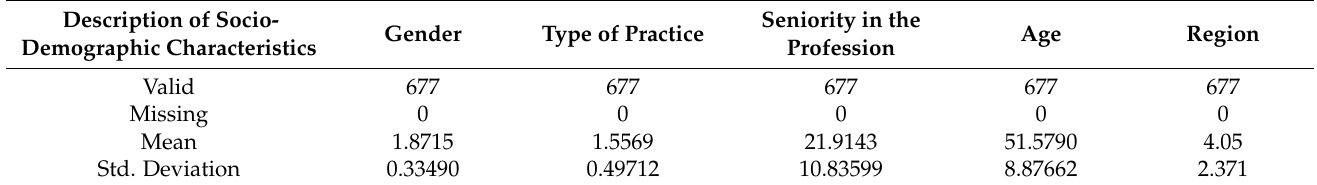
Table 1. Description of socio-demographic characteristics.